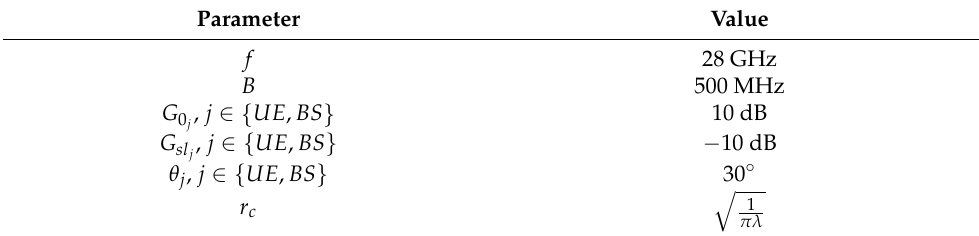
Table 3. Parameters for numerical evaluation of system model.